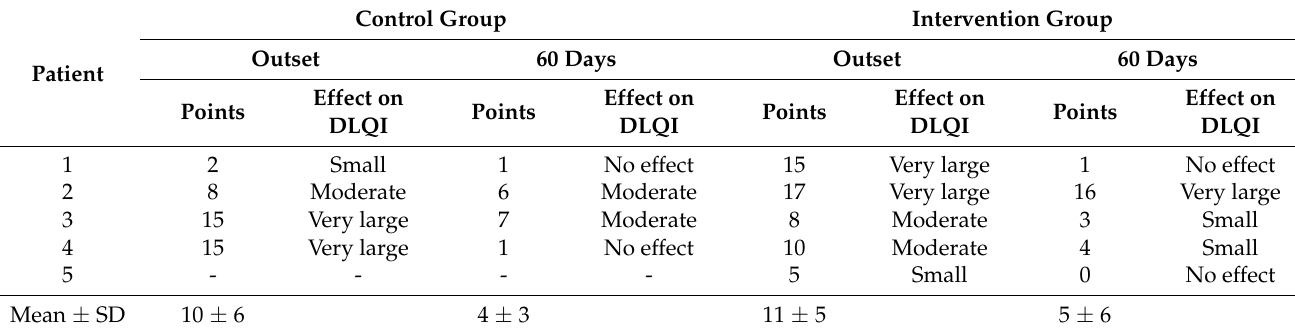
Table 4. Effect on the patient’s quality of life (DLQI) of treatment with cold creams CBlank (Control) and CPropolis (Intervention) for 60 days.